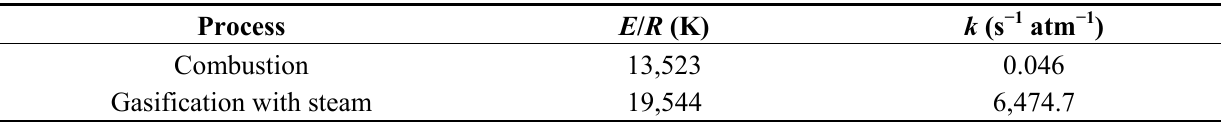
Table 2. Kinetic